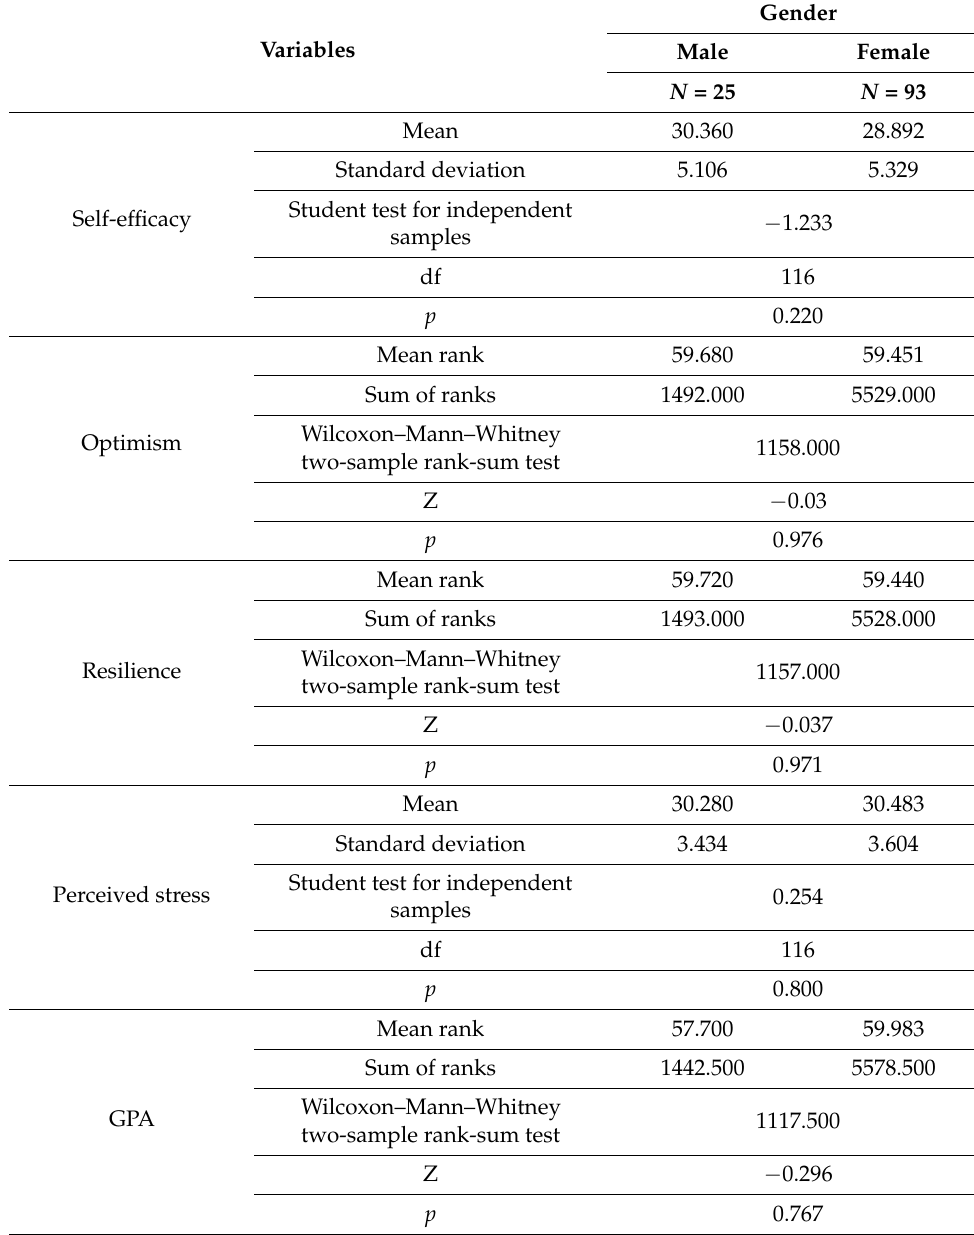
Table 6. Analysis of variables by